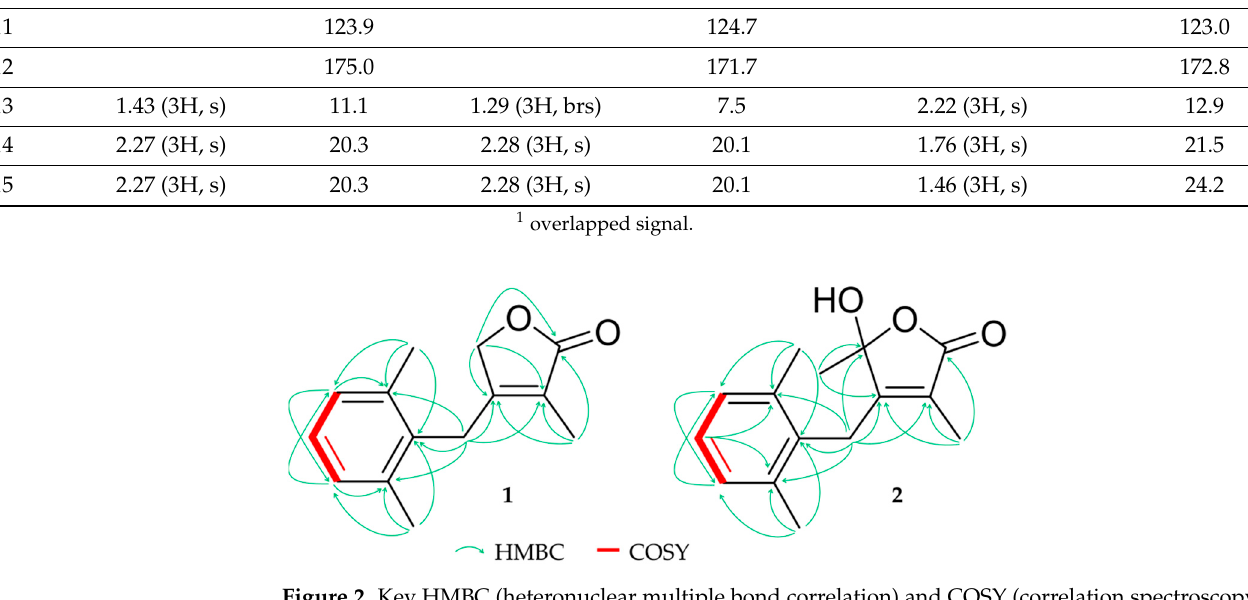
Figure 2. Key HMBC (heteronuclear multiple bond correlation) and COSY (correlation spectroscopy) correlations for compounds 1 and 2 .